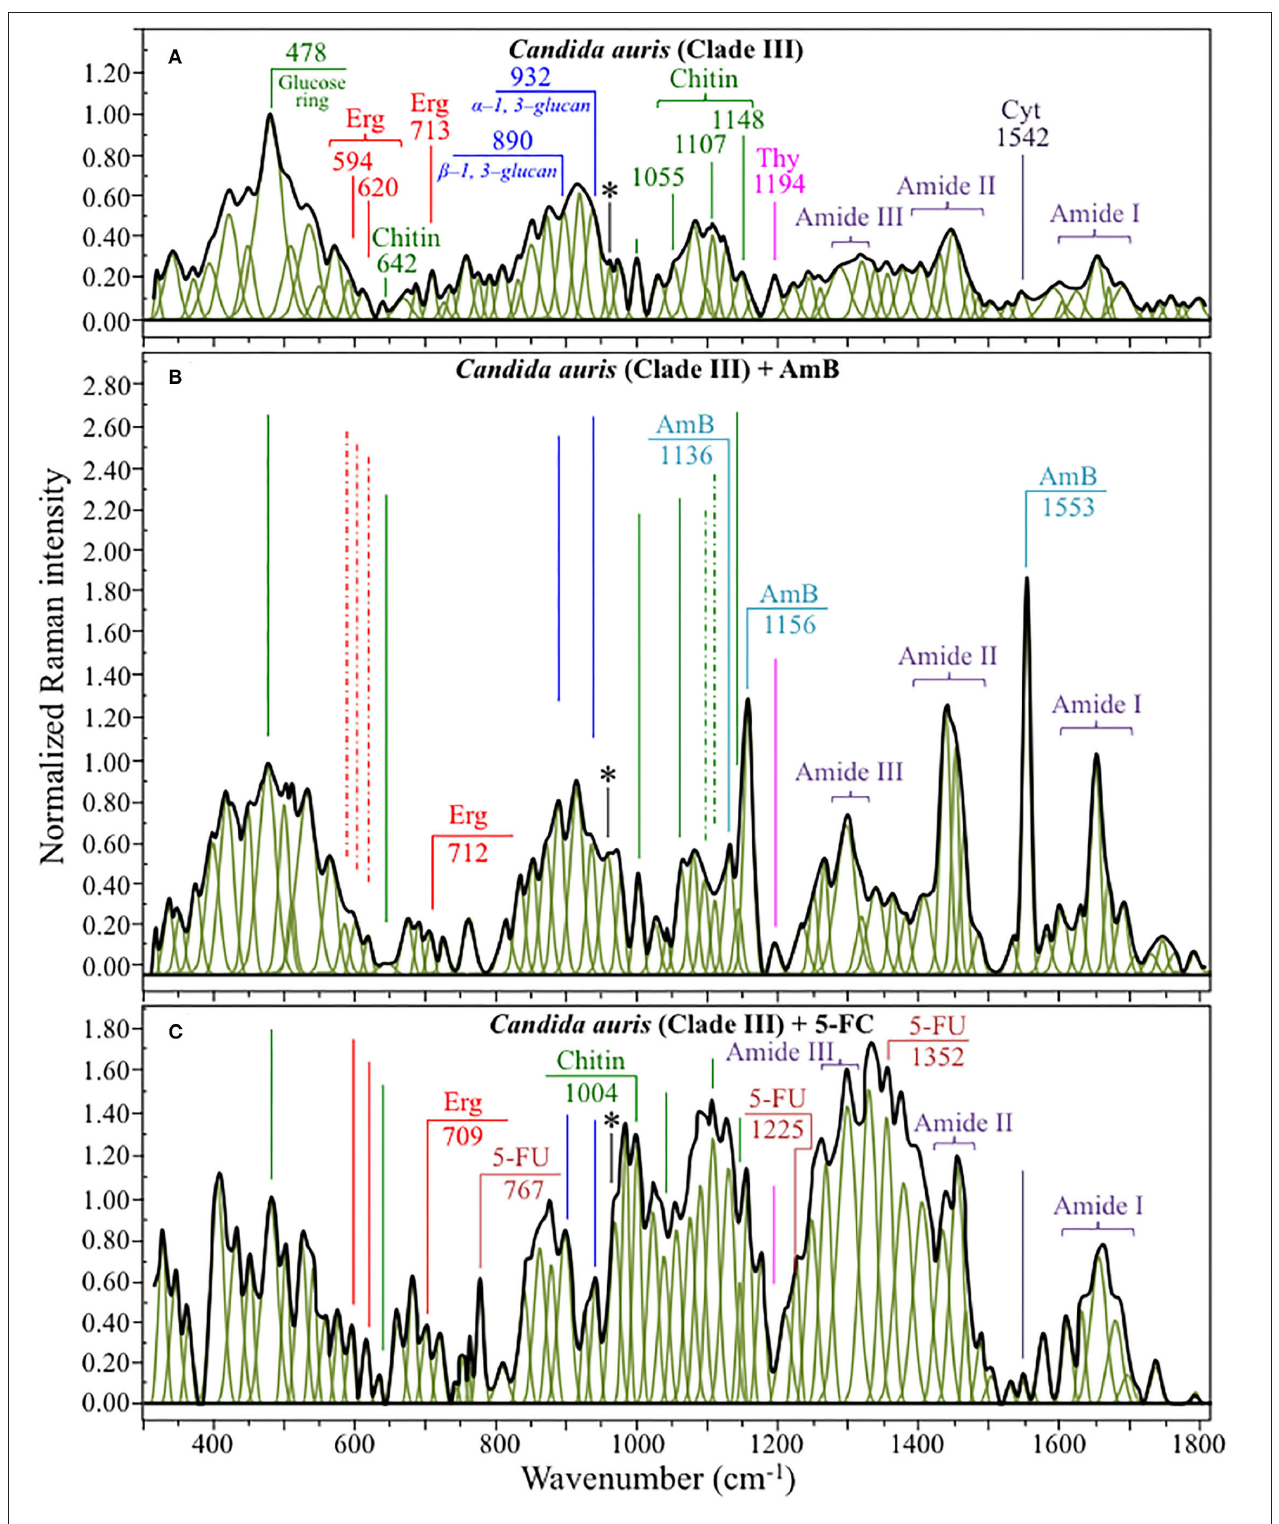
FIGURE 5 | Average Raman spectra of C. auris Clades III in the wavenumber interval 300 ∼ 1,800 cm − 1 ; sections (A–C) correspond to as cultured cells, and cells treated with AmB and 5-FC, respectively. Spectra are normalized to the glucose ring band at 478 cm − 1 and deconvoluted into Lorentzian/Gaussian sub-bands by means of the machine-learning algorithm described in Section Spectral Treatments and Deconvolution. The asterisk locates the C-CH 3 deformation band at 956 cm − 1 .